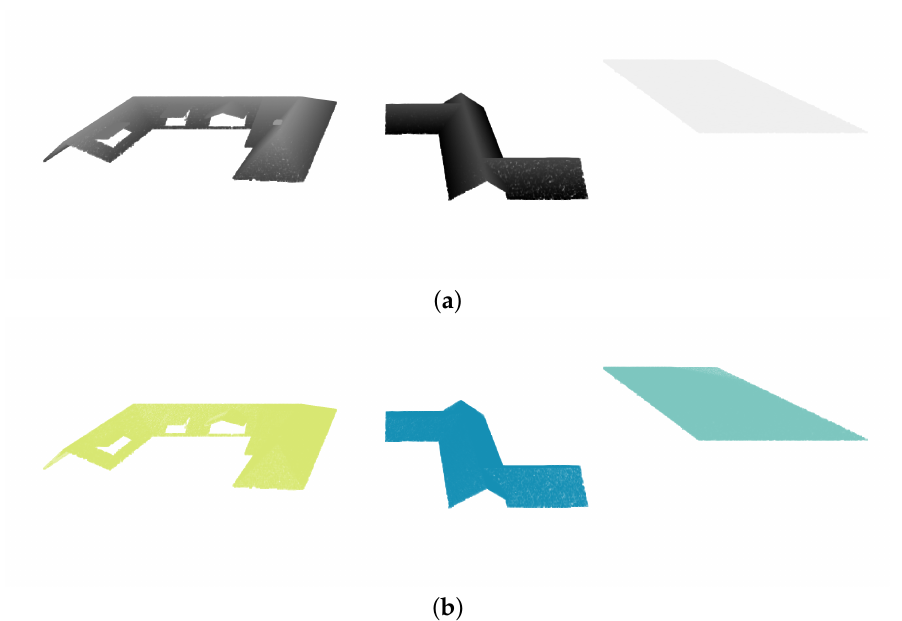
Figure 2. Illustration of clustering a point cloud by position, where the input points on top ( a ) are coloured by their height and the points in the bottom ( b ) in regard to which building point set they correspond to.